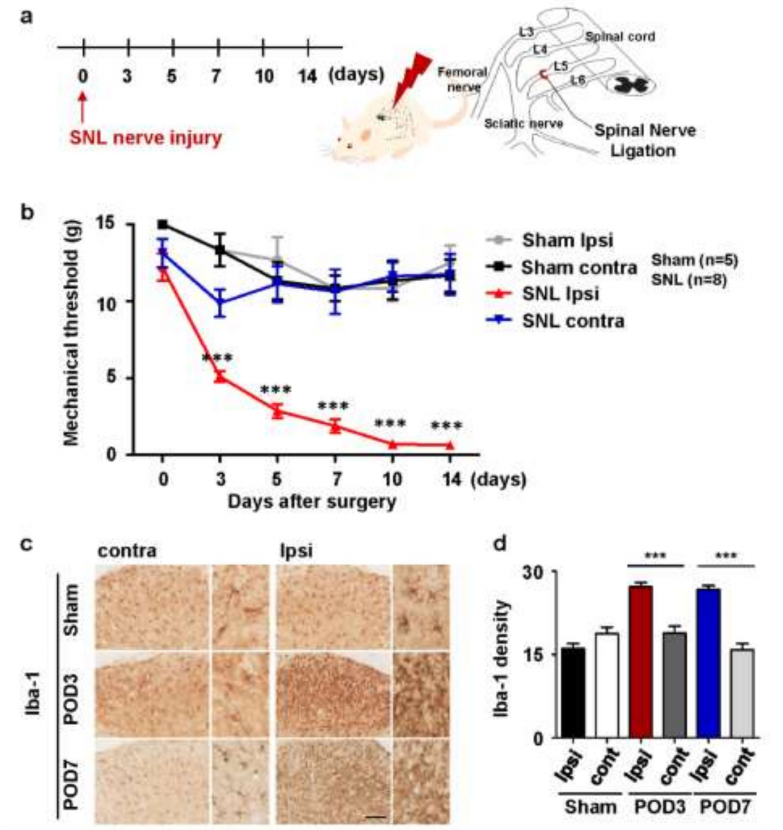
Figure 1. Microglial activation was induced by L5 spinal nerve ligation (SNL) in the rat neuropathic pain model. ( a ) Neuropathic pain was induced by ligation of L5. ( b ) Rats were then subjected to